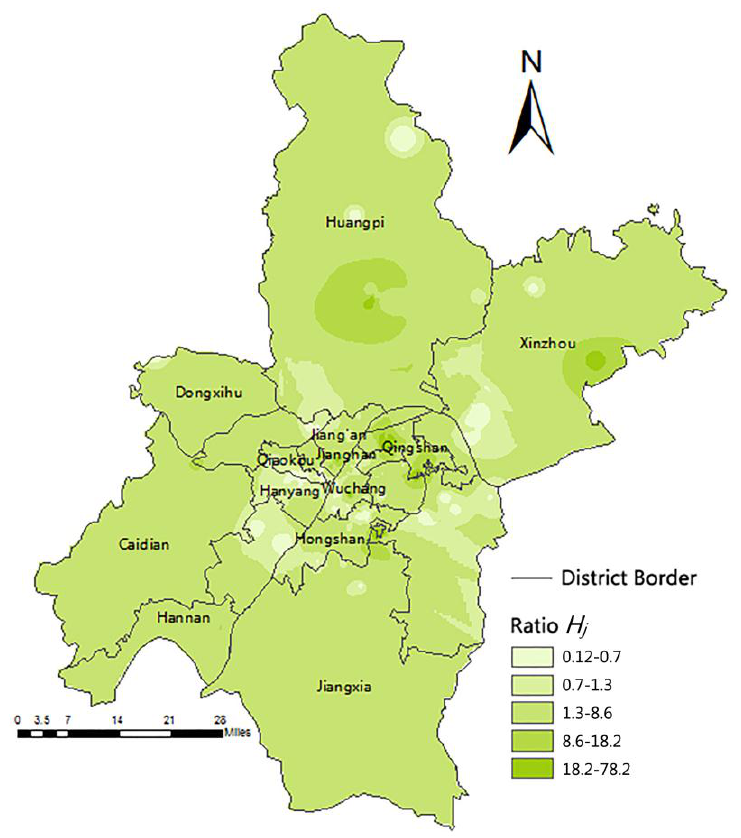
Figure 4. Ratio of potential daily outpatients and actual daily average of outpatients of each hospital in Wuhan in hypsometric layers.